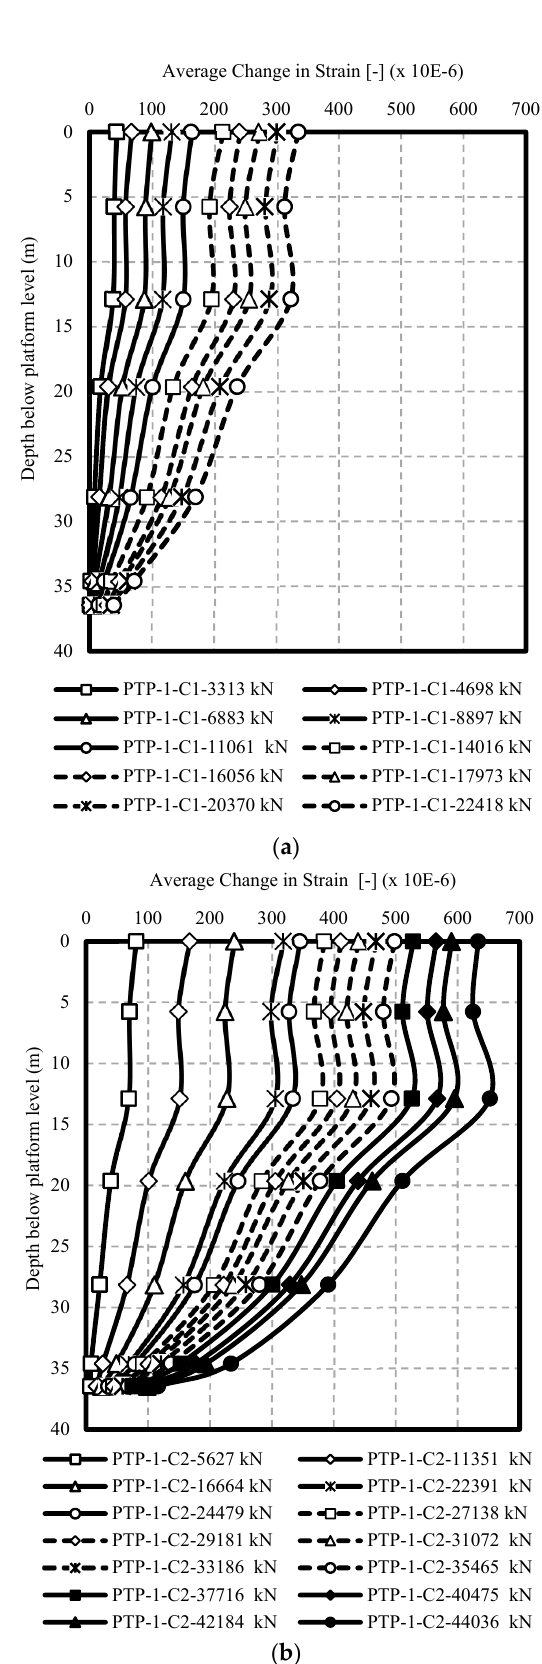
Figure 13. Distribution of average change in strain measured along BP# 1 in ( a ) 1st cycle and ( b ) 2nd cycle.